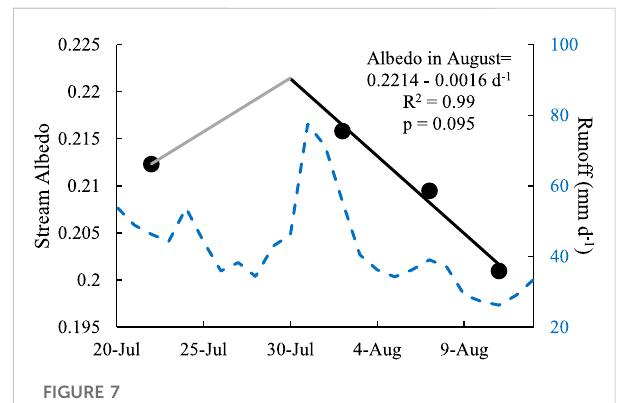
FIGURE 7 Albedo of the main stream channel for the overlapping area of the four largest coverage fl ights (i.e., large scene area). Albedo was calculated based on the percent coverage of sediment and water using,an albedovalueof0.26for water(Ryan etal.,2018),andan albedo value of 0.07 for sediment. A segmented line (where the second part of the line is a regression calculated with the equation shown above) has been added to support the hypothesis made in Section 5.2 that stream albedo increases before peak discharge as sediment is eroded and then decreases after peak discharge as sediment is deposited. Runoff values (blue stipple line) are daily averaged runoff values from the MAR v3.11.5 regional climate